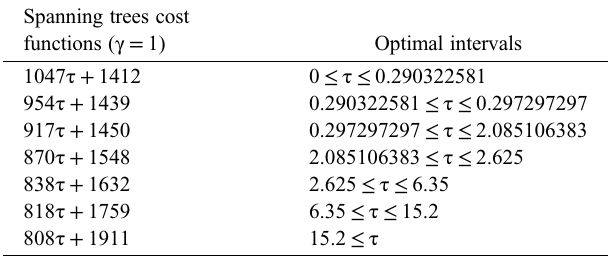
CTP optimal spanning trees cost functions for RSP1 Spanning trees cost